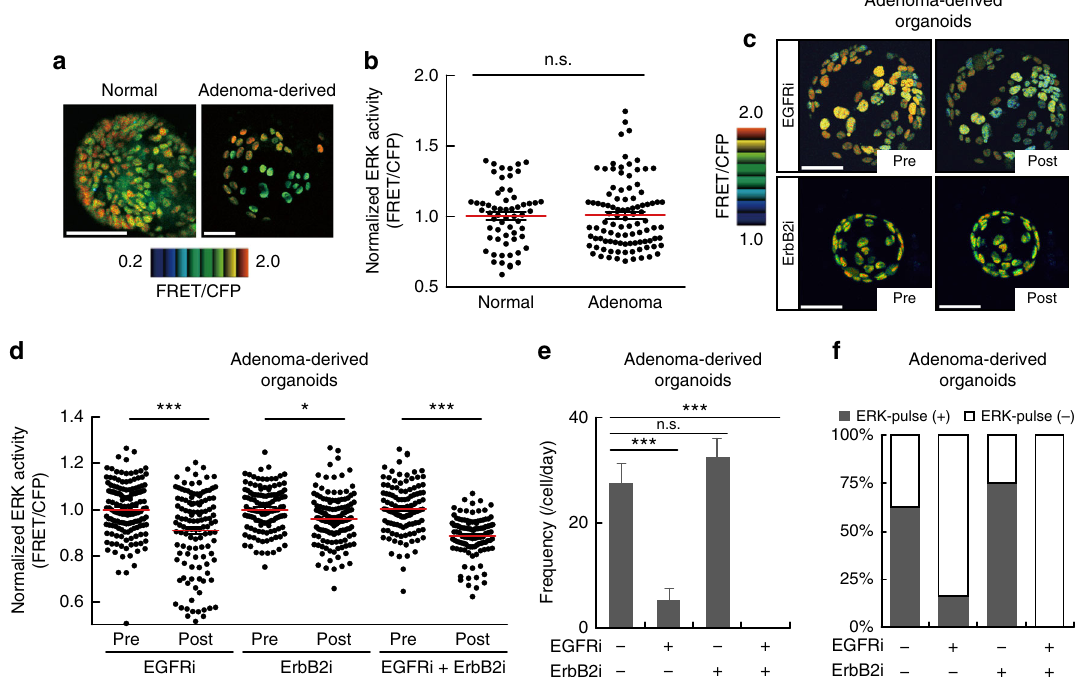
Fig. 5 Adenoma-derived organoids exhibit increased dependence on EGFR signalling. a , b Organoids were generated from the normal epithelium or adenomas of the Apc Δ 716 mouse small intestine, and infected with lentiviruses expressing a FRET biosensor for ERK activity (EKAREV-NLS). a Representative images of ERK activity (FRET/CFP ratio) in organoids derived from the normal epithelium and adenomas. b Bee swarm plots of ERK activity in the normal epithelium-derived and adenoma-derived organoids (Normal: n = 61, Adenoma: n = 99 cells, from more than three organoids). c – f Adenoma-derived organoids expressing EKAREV-NLS were treated with 1 μ M of an EGFR inhibitor (EGFRi), PD153035, and/or 10 μ M of an ErbB2 inhibitor (ErbB2i), CP-724714. c Representative images of adenoma-derived organoids before and after treatment with EGFRi or ErbB2i. d Bee swarm plots of ERK activity before and after inhibitor treatment (EGFRi: n = 120, ErbB2i: n = 119, EGFRi + ErbB2i: n = 109 cells, pooled from three organoids). e , f Quanti fi cation of ERK activity pulses in adenoma-derived organoids. Organoids were treated with EGFR and/or ErbB2 inhibitors, and then imaged for 90 min. ERK activity data from each cell were processed as described for Fig. 4e ( − / − : n = 40, EGFRi/ − : n = 45, − /ErbB2i: n = 32, EGFRi/ErbB2i: n = 29 cells). Frequencies of the pulse-like ERK activity ( e ) and the proportion of cells with pulse-like ERK activity (ERK-pulse + ) ( f ) under each condition. Scale bars, 50 µ m. Red lines represent mean. Error bars represent s.e.m. Mann – Whitney U -test ( b , d ) and Steel – Dwass test ( e ) were used for comparison. * P < 0.05, ** P < 0.001, *** P < 0.0001, n.s., not signi fi